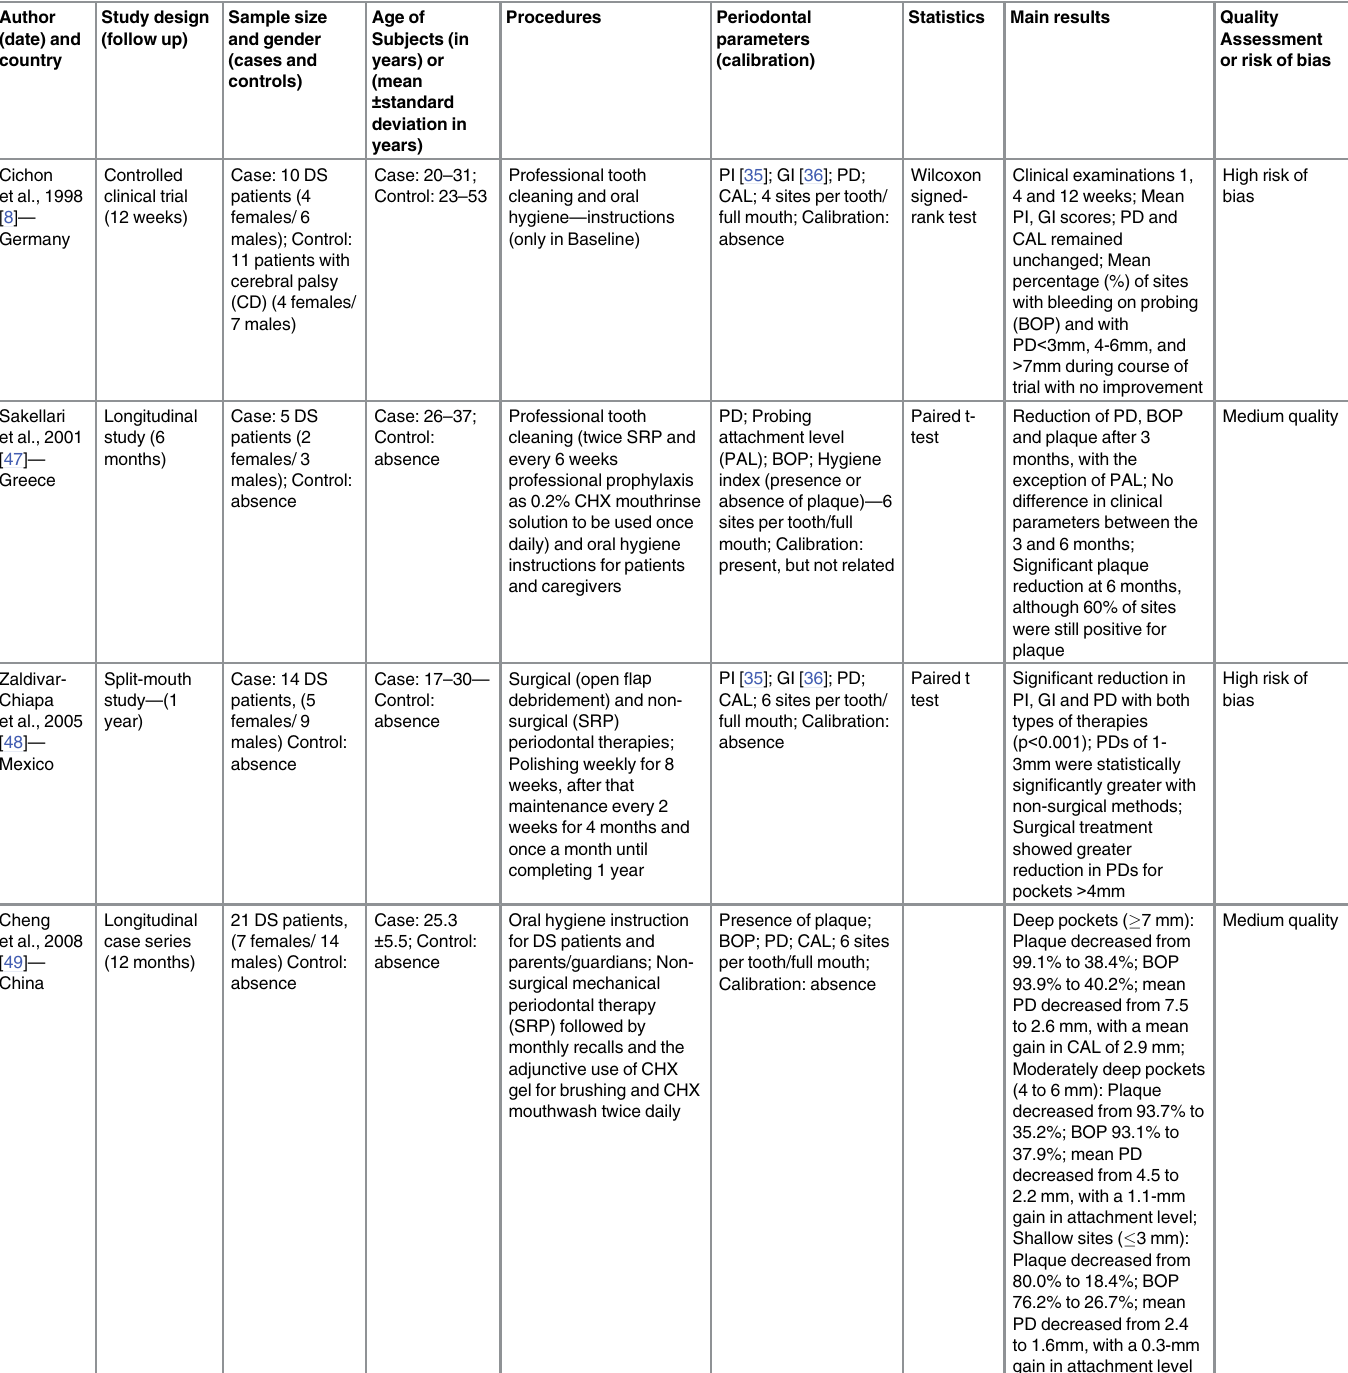
Table 2. Characteristics of included studies about